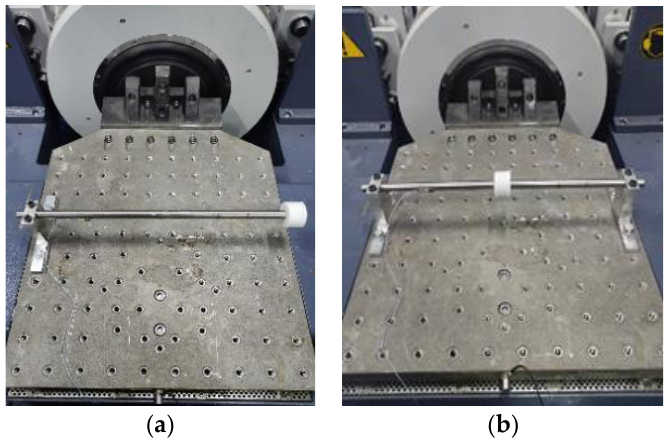
Figure 17. Two kinds of boundary conditions. ( a ) Fix-free; ( b ) Fix-Fix.